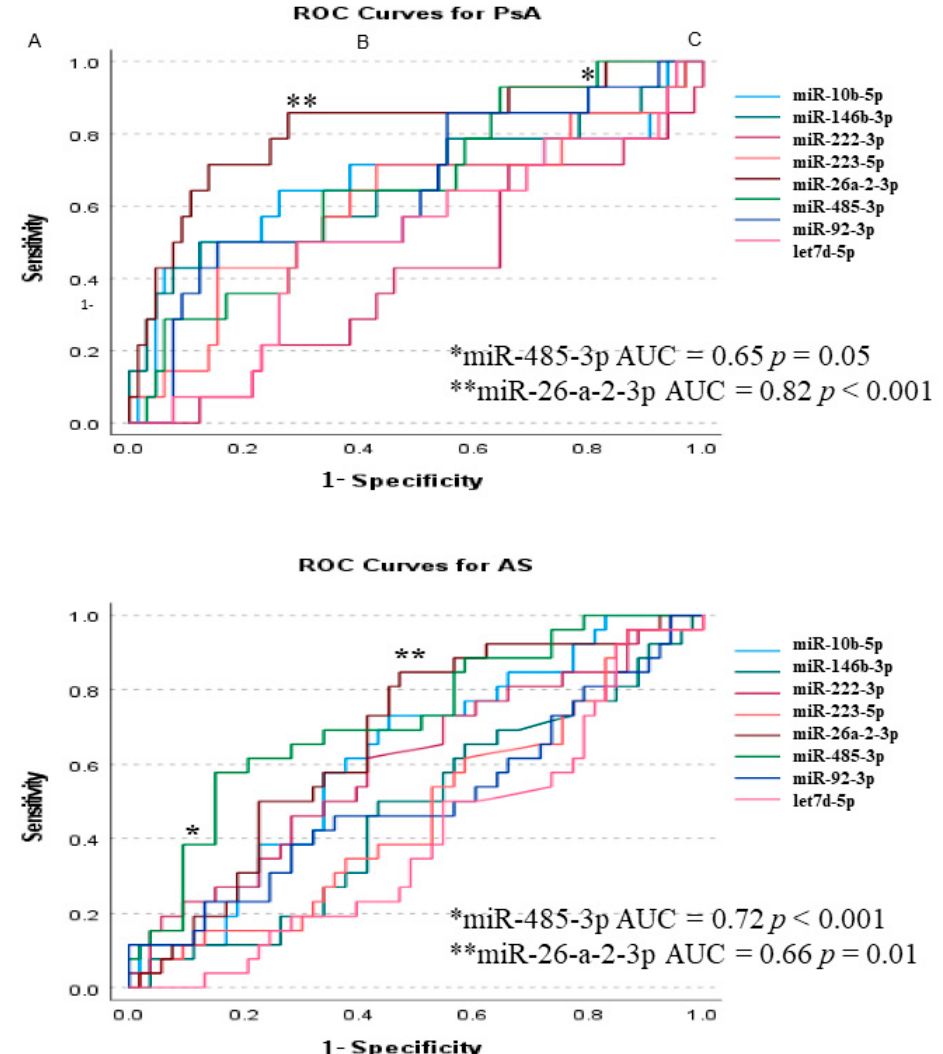
Figure 5. ROC curves for diagnosis of PsA, AS, and RA. p -values < 0.05 are expressed as * and p -values < 0.001 as